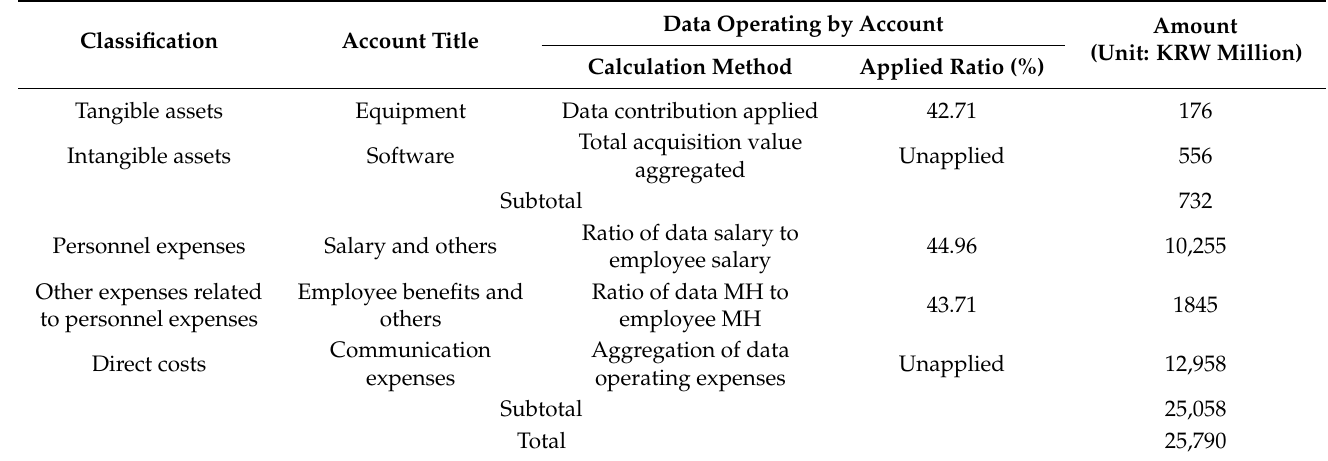
Table 9. Results of data value calculation based on the cost approach before reflecting economic indicators.